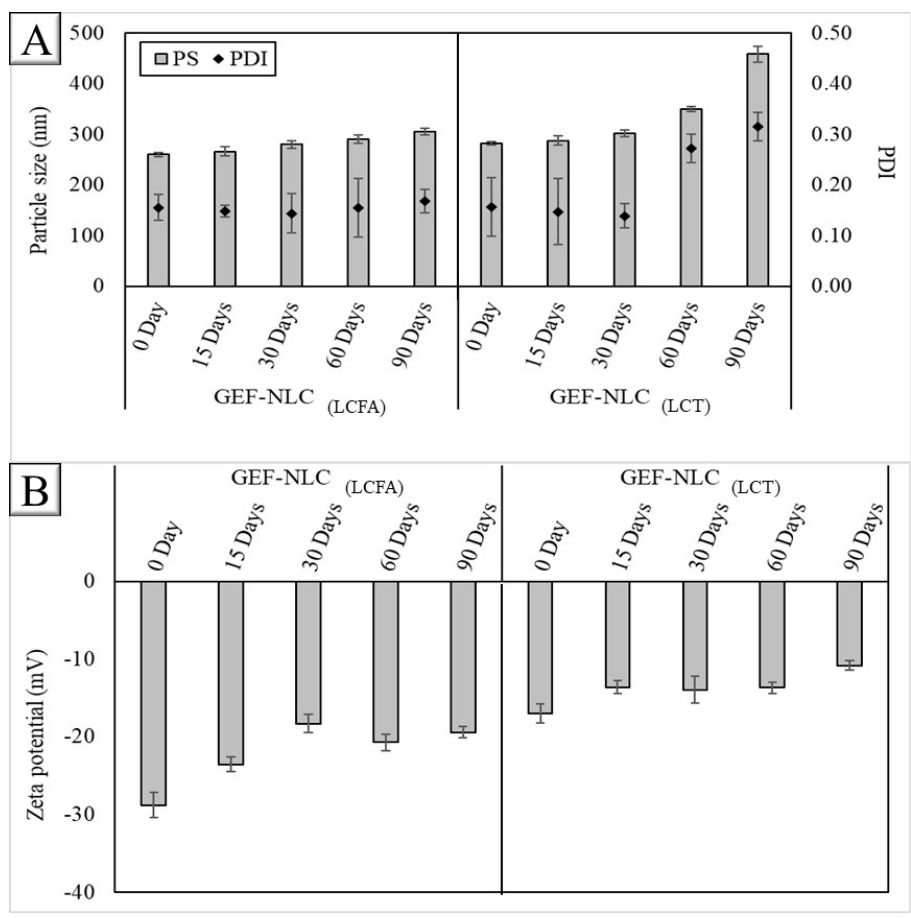
Figure 10. ( A ) Particle size and PDI and ( B ) zeta potential values of GEF-NLC (LCFA) and GEF- NLC (LCT) . Data are expressed as the mean ± SD, N = 3.